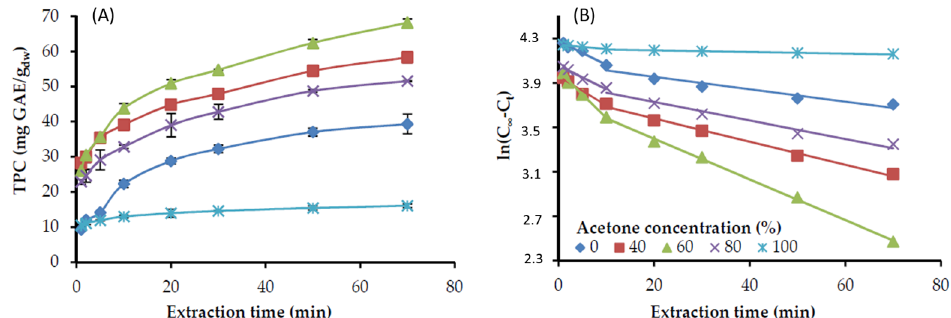
Figure 2. Phenolic compounds extraction from distilled, ground rosemary leaves at different acetone concentration in the aqueous solution, 22 °C, and the solid-to-liquid ratio of 1:20 g/mL. ( A ) Experimental values of total phenols recovery (TPC) versus extraction time; ( B ) the factor ln(C ∞ − C t ) versus extraction time, approximation curves based on the diffusion model, according to Equation (1).